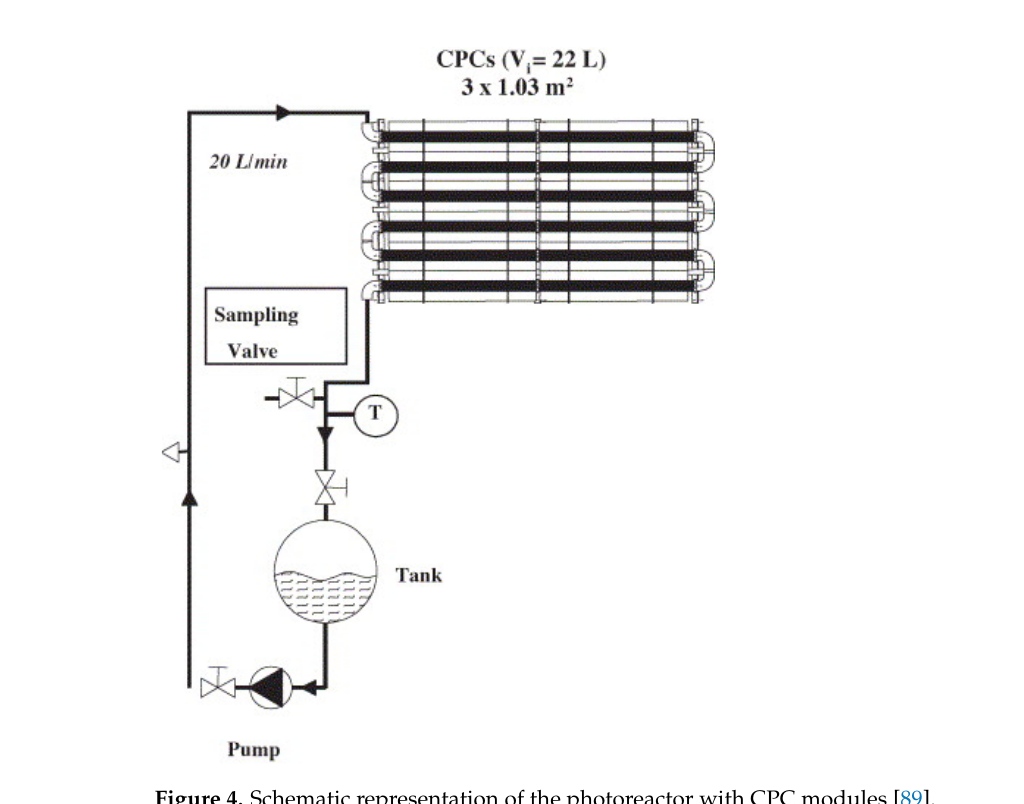
Figure 4. Schematic representation of the photoreactor with CPC modules [89].